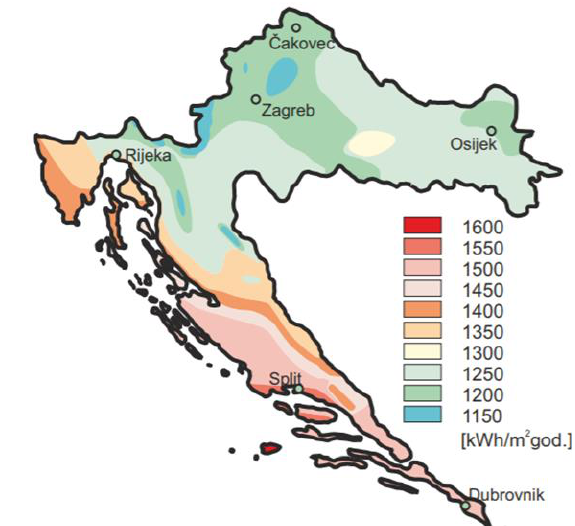
Figure 1 . Mean annual amounts of global solar radiation on the horizontal surface in kWh/m 2 (Termorad, 2020)